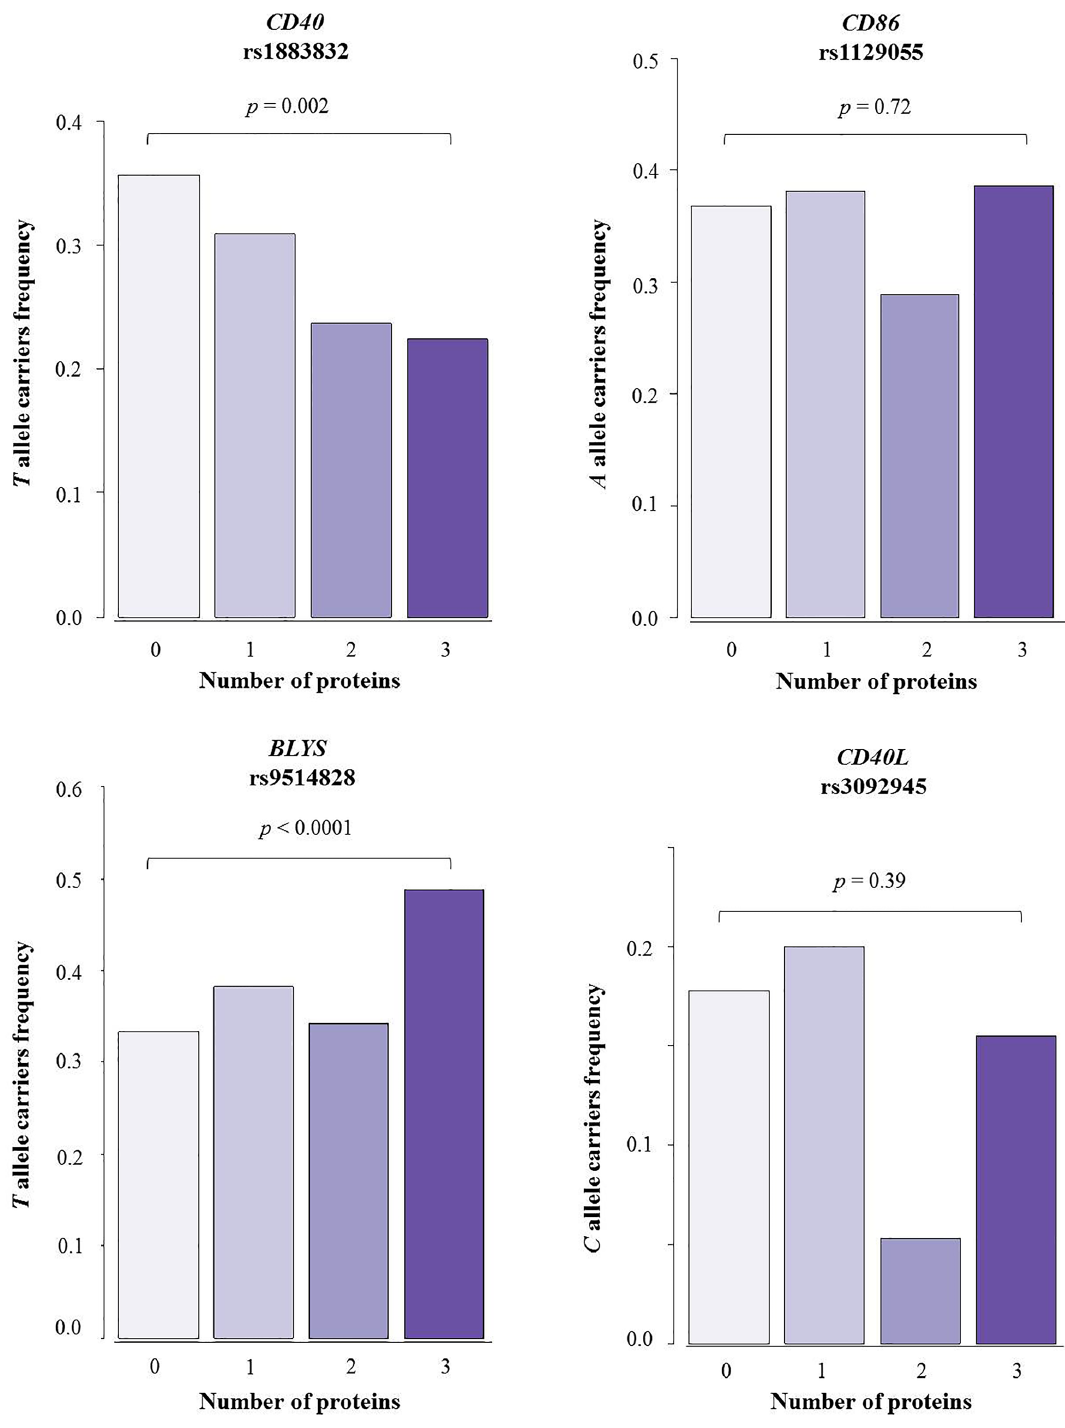
Fig 1. Positive antibody response and carrier frequency of mutant alleles. Frequency of carriers of mutant alleles of SNPs in genes CD40 , BLYS , CD86 , and CD40L according to the number of proteins for which subjects were responders. Individuals with antibodies against the three proteins (n = 279) were classified according to their reaction against zero (n = 57), one (n = 55), two (n = 38), or three (n = 129) proteins of blood-stage P . vivax .